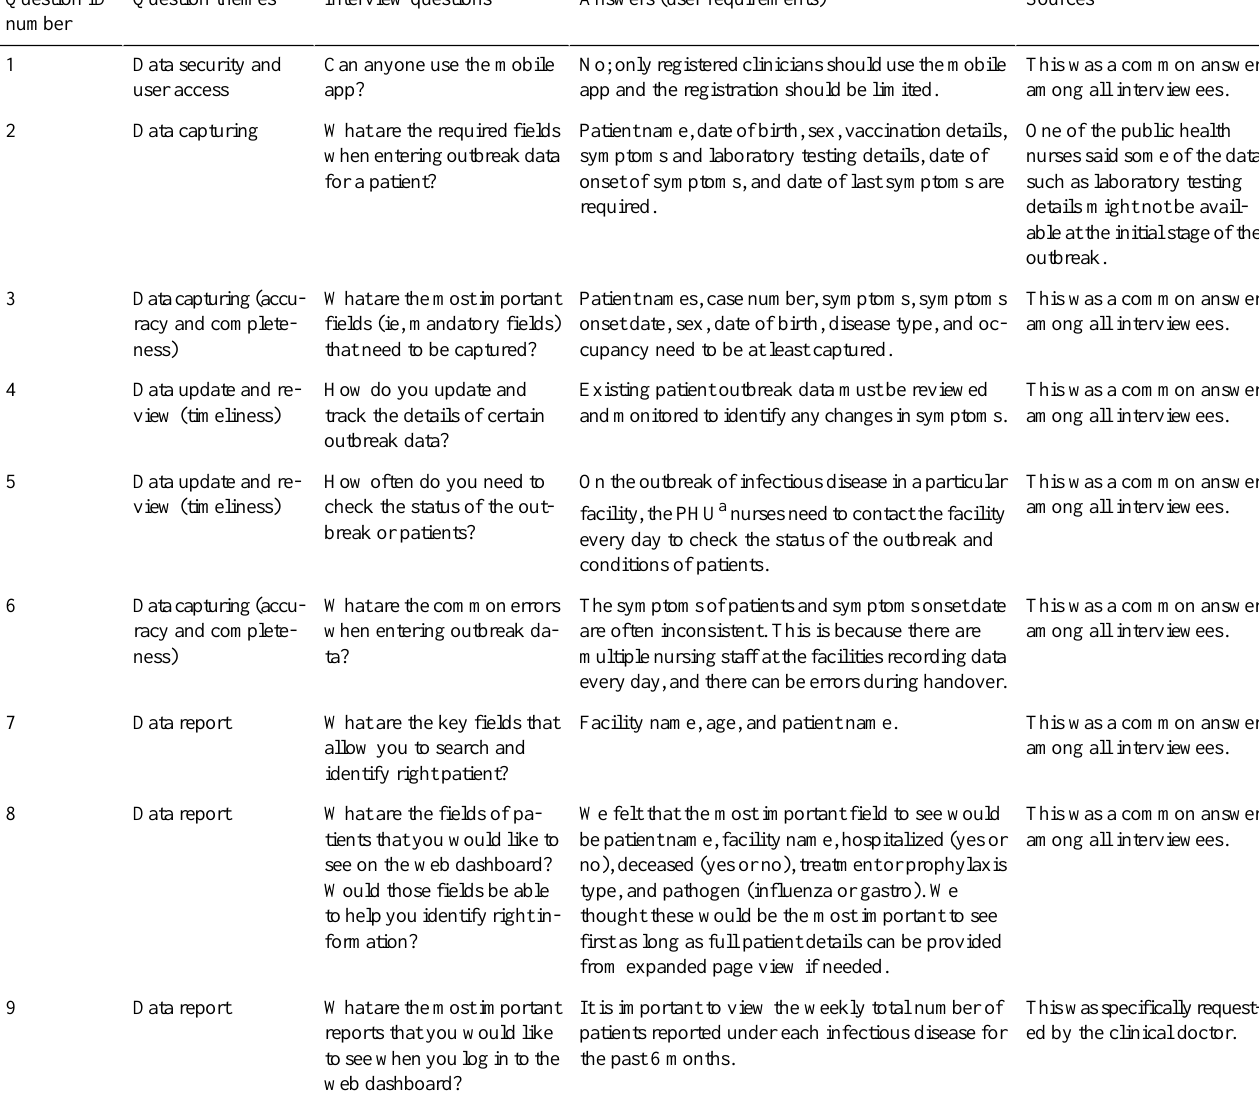
Table 2. The list of interview questions and corresponding answers to understand the context of